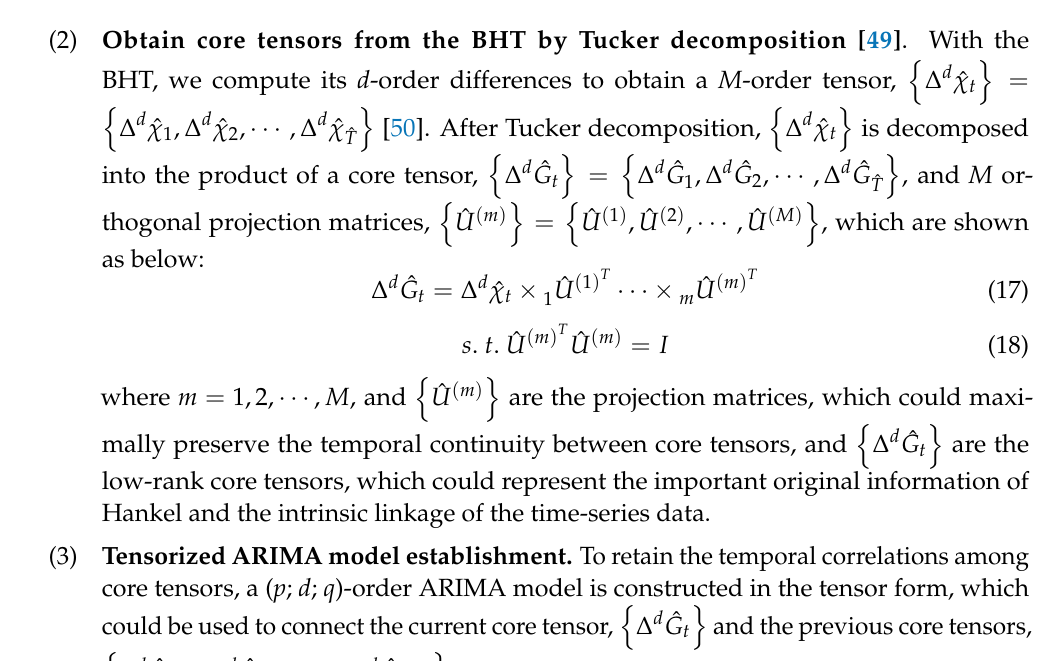
Figure 4. Method of obtaining the high-order multidimensional short time-series data using MDT. ( a ) depicts the first step that all layers of the optimal weighted VI group were decomposed in the time dimension to get { χ } . ( b ) depicts the step that { χ } was stretched by the replication matrix to get { χ } shown in ( c I × τ × T